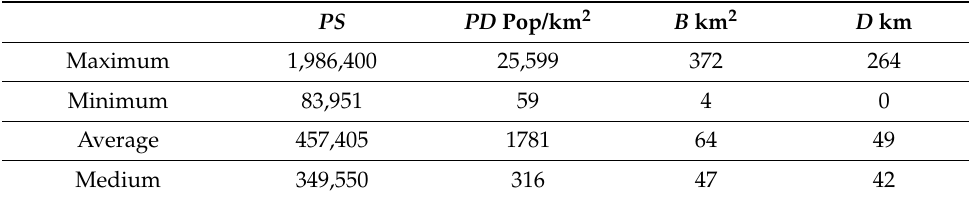
Table 1. Variable statistics in the index of relative rurality.